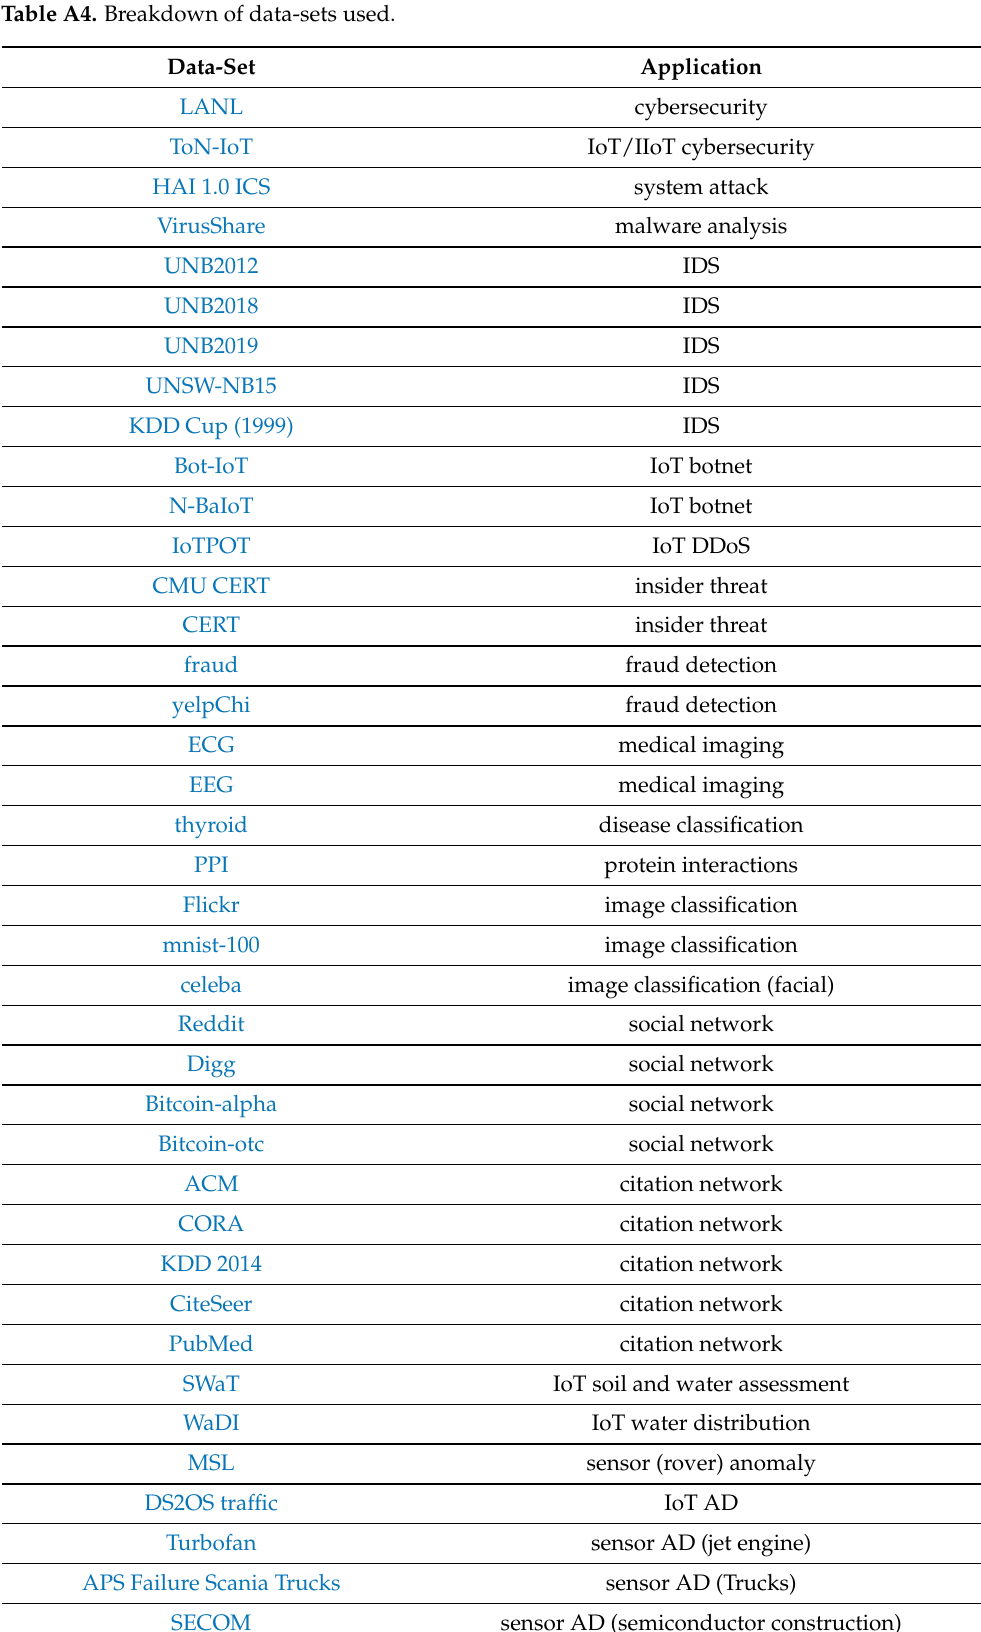
Table A4. Breakdown of data-sets